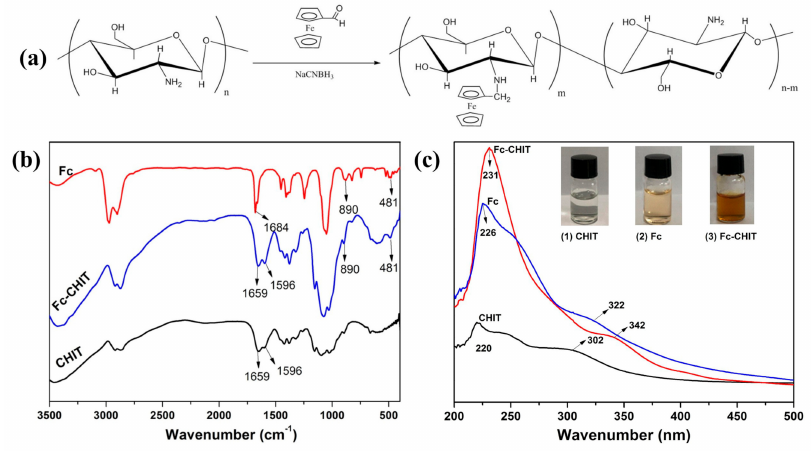
Figure 1. ( a ) Reaction scheme of CHIT and Fc; ( b ) FT-IR and ( c ) UV spectra of CHIT, Fc and Fc-CHIT.